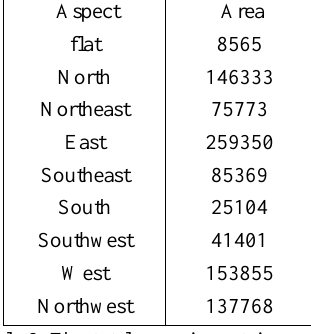
Table 2. The total areas in certain aspect ranges.